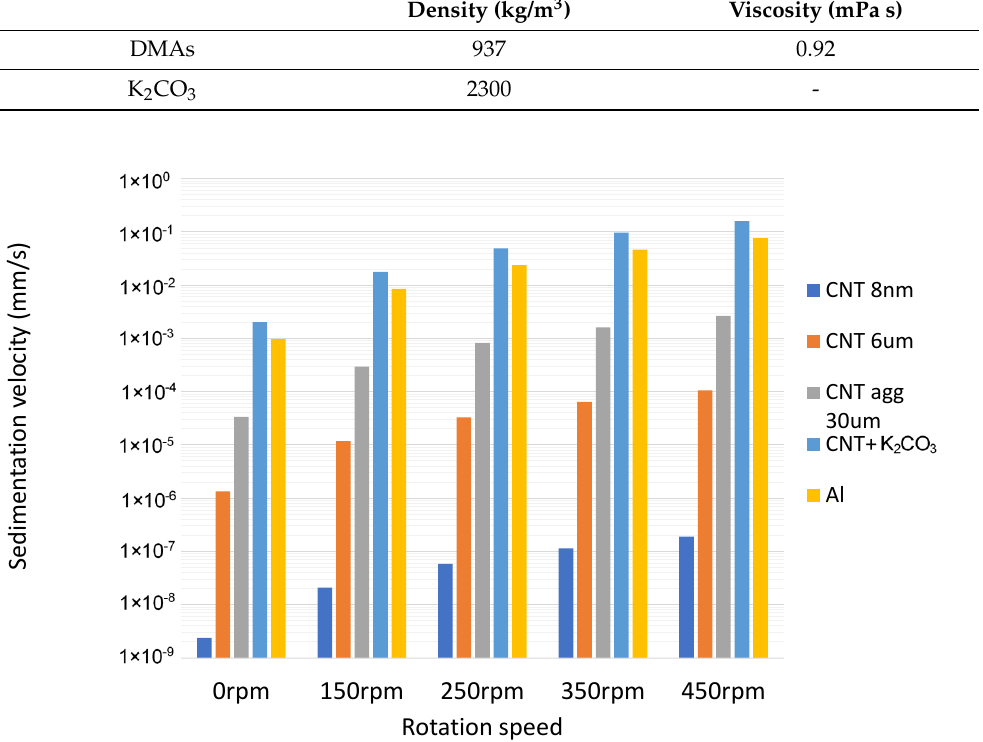
Figure 12. Sedimentation velocity of Al powders and CNT with variety of rotation speeds from 150 to 450 rpm.